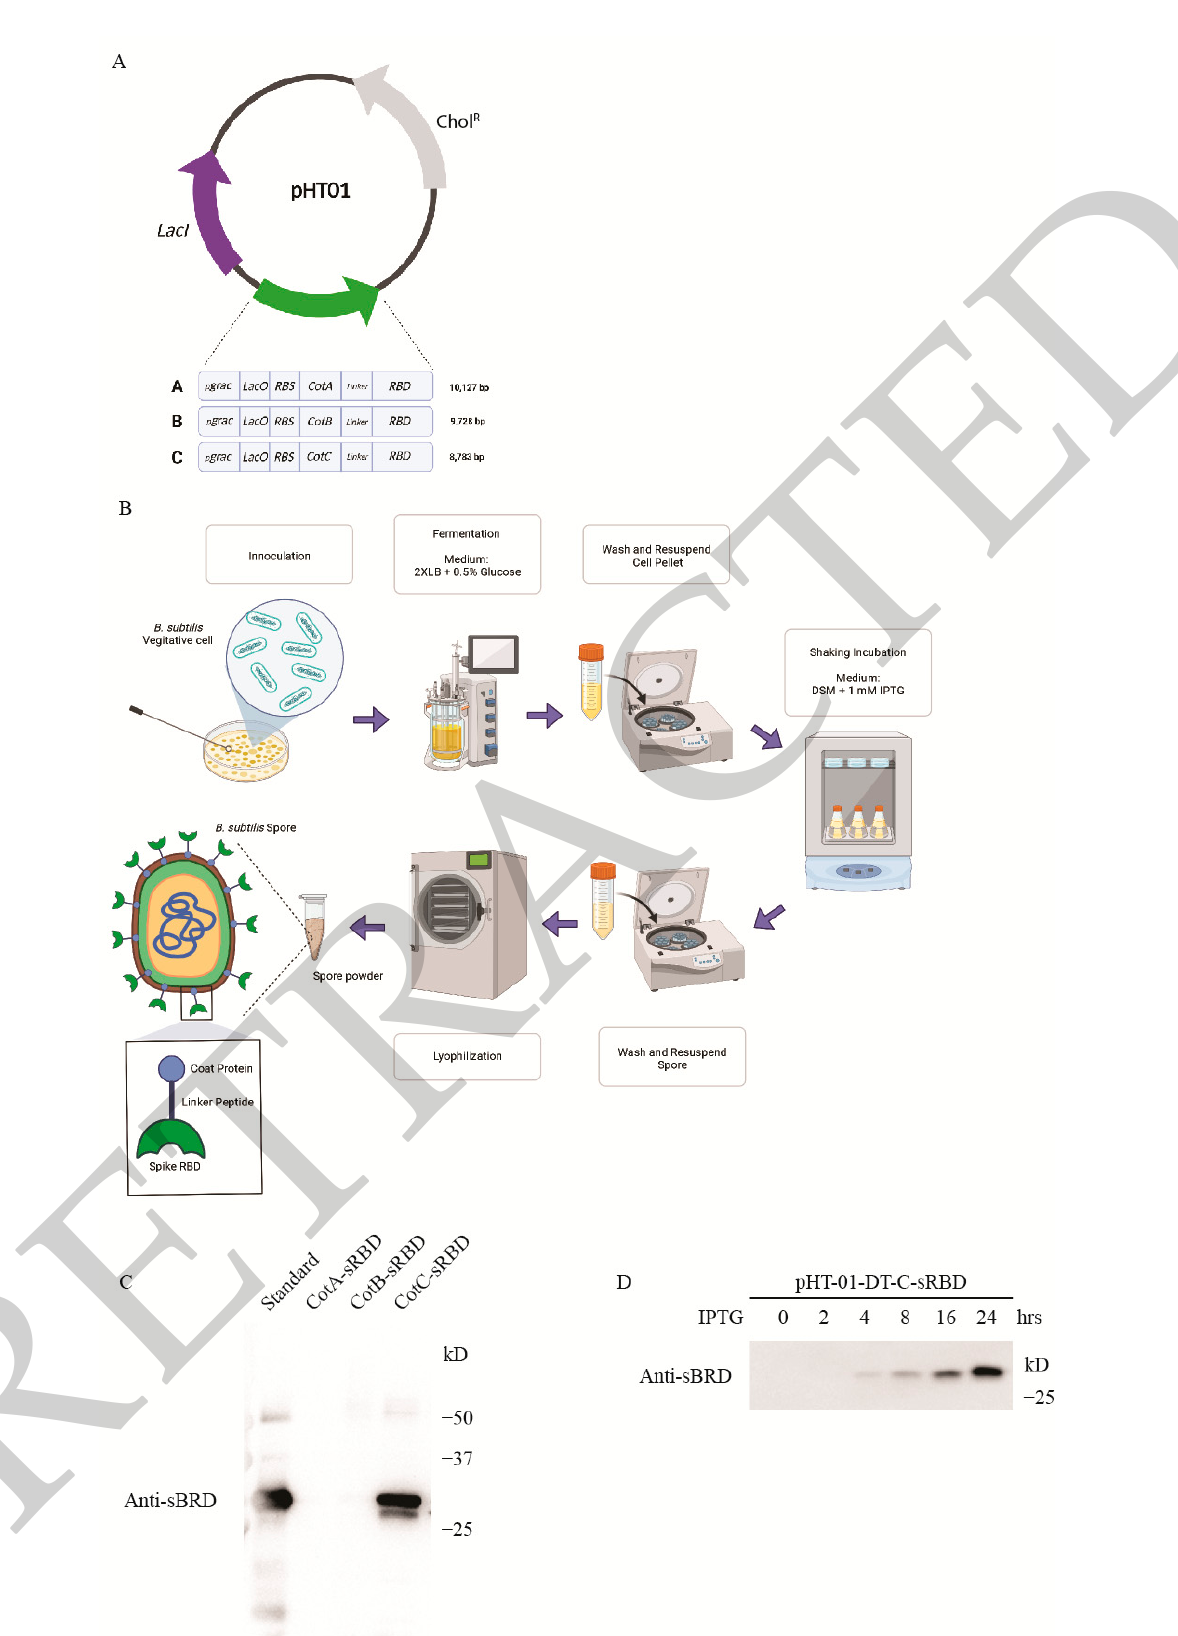
Figure 1. ( A ) Schematic representation of DNA constructs: a. pHT01-DT-A-sRBD; b. pHT01-DT-B- sRBD; c. pHT01-DT-C-sRBD constructed for displaying sRBD on the surface of the spore.